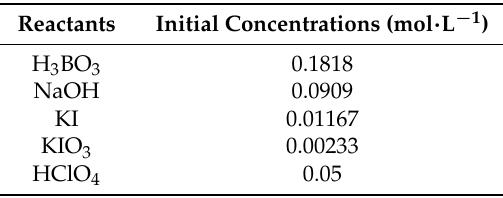
Table 1. Initial concentrations of used